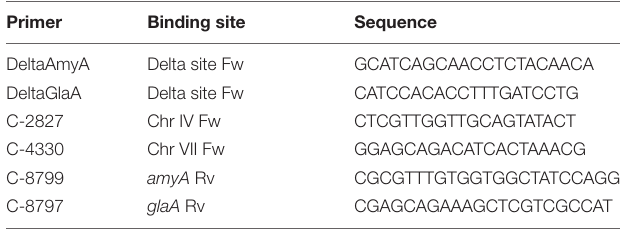
TABLE 4 | Primers used to confirm the integration of heterologous amyA and glaA genes in S. cerevisiae . Primer Binding site